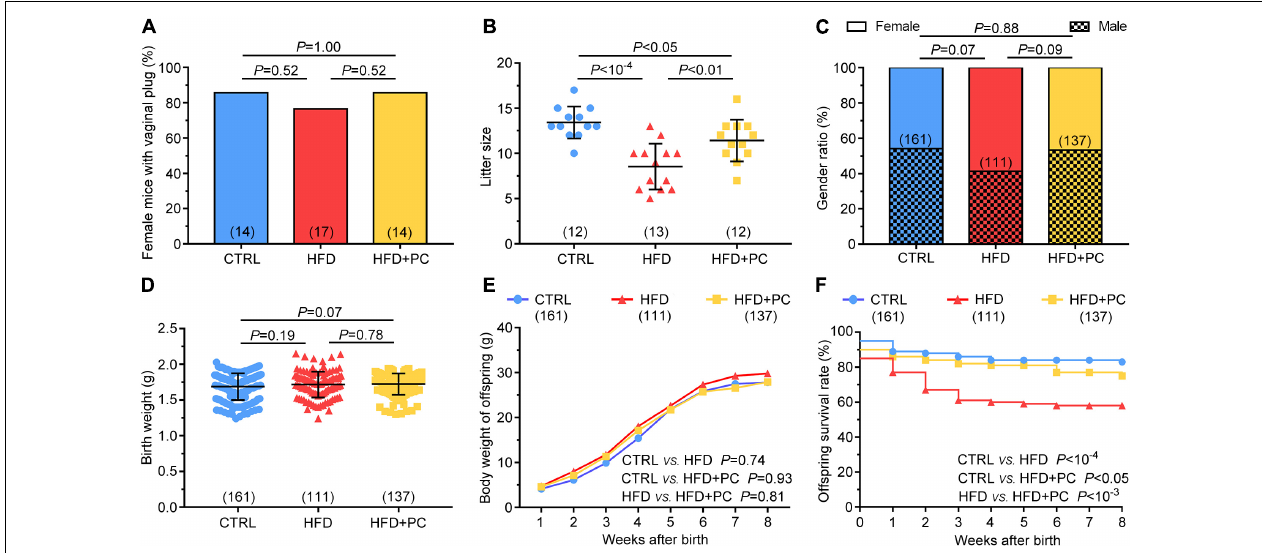
FIGURE 2 | PC increased litter sizes and offspring viability in obese female mice. (A) A comparison of mating rates in female mice. (B) Offspring litter sizes. (C) The gender ratios for offspring. (D) Offspring birth weights. (E) Body weights for offspring (1–8 weeks of age). (F) Offspring survival rates (0–8 weeks of age). Data are expressed as mean ± SD and were compared by one-way ANOVA and Newman–Keuls post hoc tests for (B,C) , chi-squared tests for (A,E) , log-rank tests (Mantel-Cox) for (D,F) . The number of mice in each group is shown in